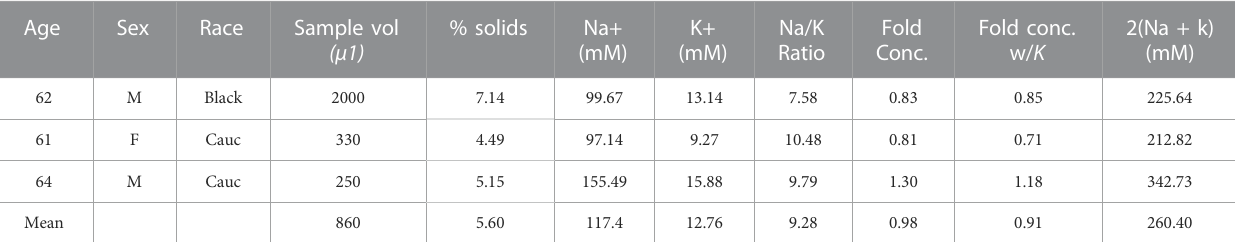
TABLE 2 Non-isotonic (MIX) Samples — 3 ETT samples collected the week of 01/22/2020-01/29/2020 were found to have a physiological Na + and K + concentrations but had a pooled average cation concentration satisfying isotonic constraints.